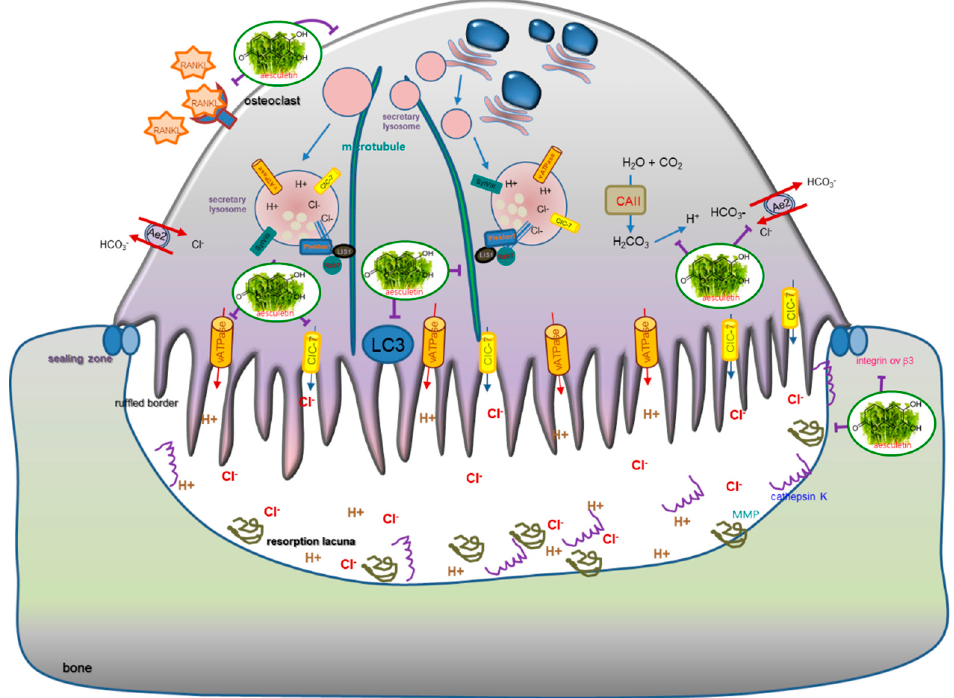
Figure 9. Schematic diagram showing the inhibitory effects of aesculetin on ruffled border formation and lysosomal trafficking responsible for bone resorption. As depicted, aesculetin blocks the RANKL signaling process responsible for bone resorption. The symbol Ͱ indicates sites of inhibition manifested by aesculetin.